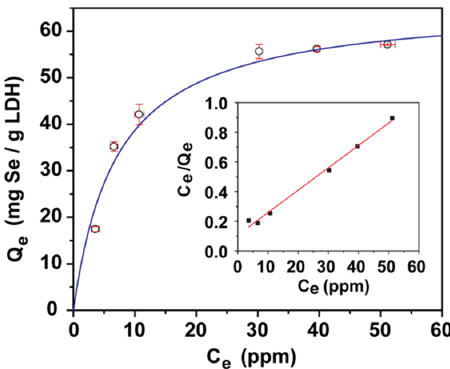
Figure 1. Adsorption isotherms of 1 g/L LDH-500C in spiked de-ionized (DI) water solutions containing Se(VI) using 22 h exposure time; inset shows the Langmuir plot.